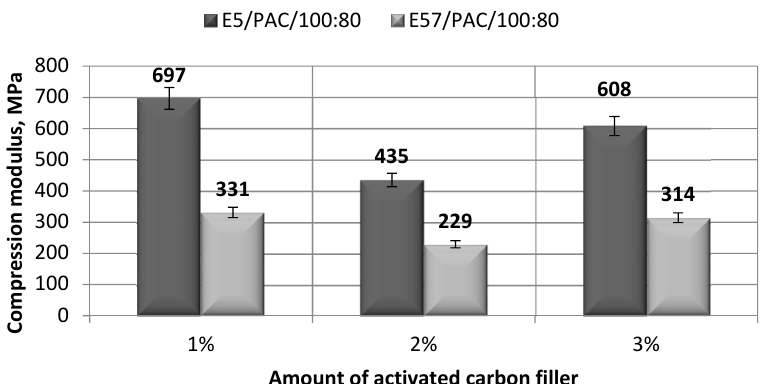
Figure 7. Comparison of the compression modulus between the E5/PAC/100:80 and E57/PAC/100:80 epoxy specimens modified by the activated carbon filler.